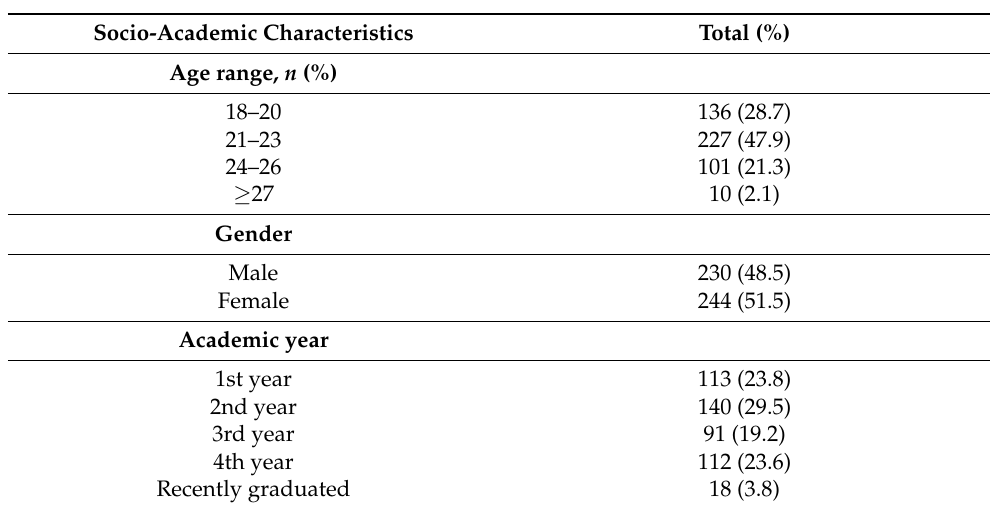
Table 2. Participants